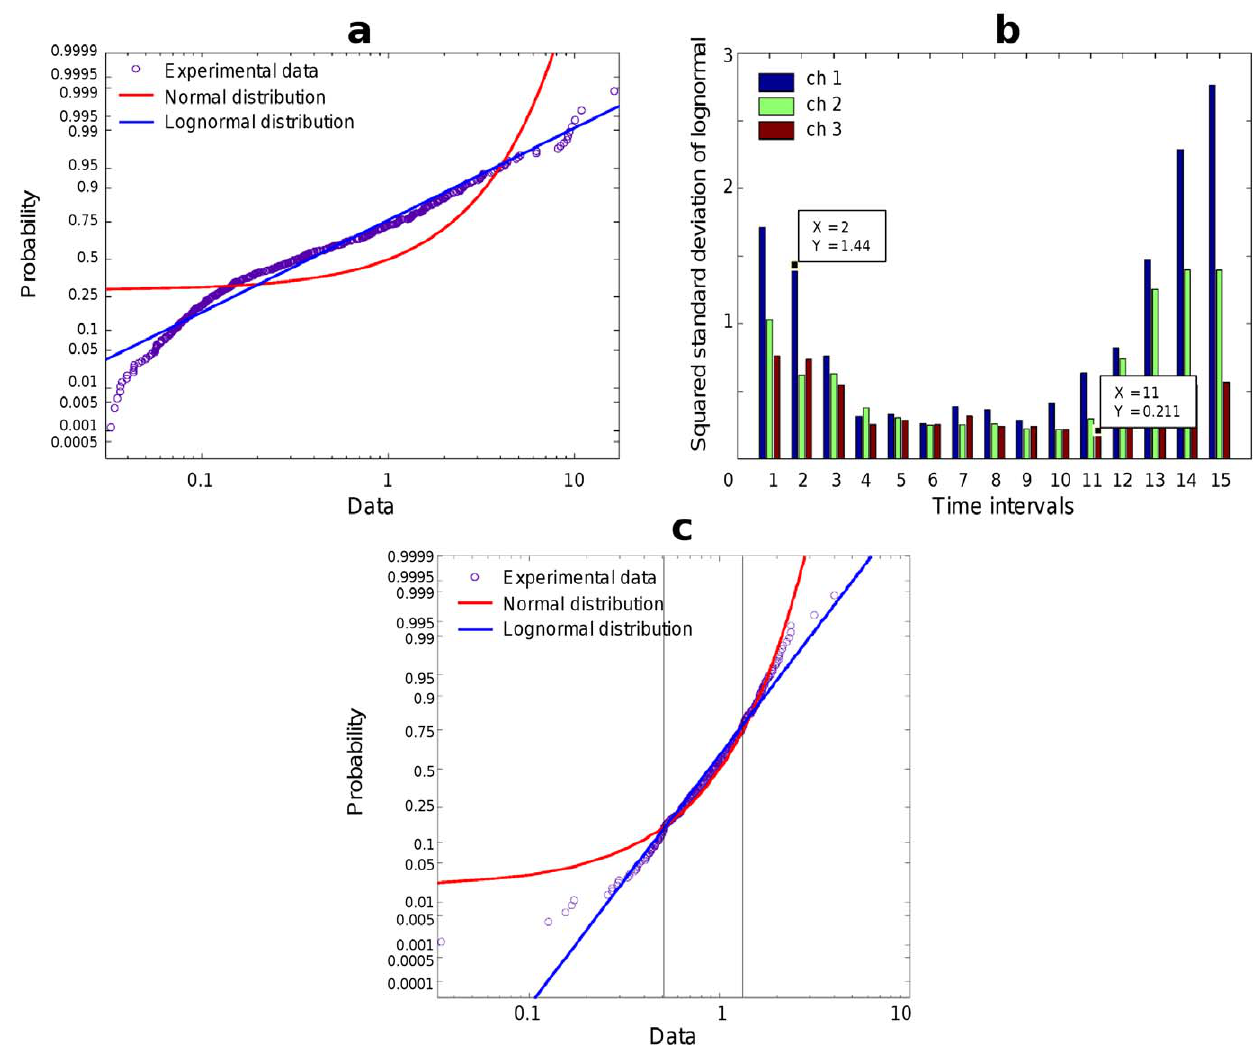
Figure 2. Probability plots. ( a ) Probability plot for experimental data for time interval 2, channel 1 ( s 2 ~ 1 : 44 ) together with probability plots for theoretical normal and lognormal distributions. ( b ) The standard deviations for the lognormal distribution. ( c ) Probability plot for experimental data for time interval 11, channel 3 (theoretical s ~ 0 : 53 is shown by vertical lines).